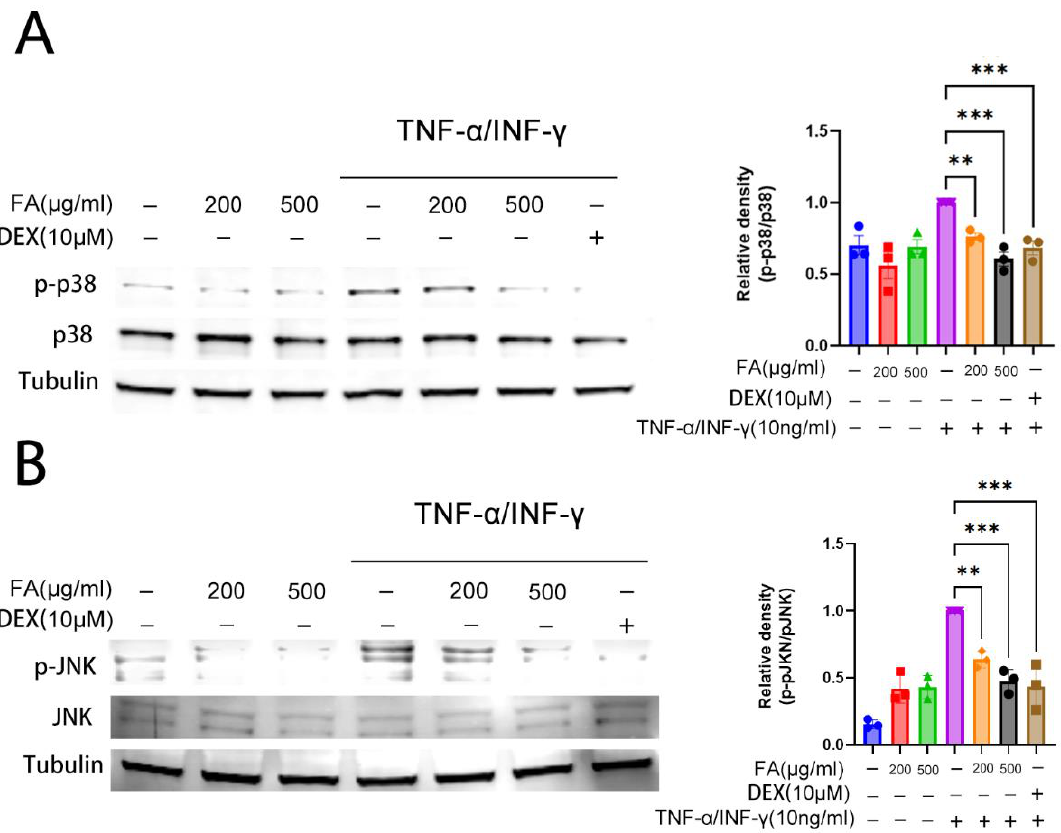
Figure 3. Effects of FA on the p38 MAPK and JNK pathways. TNF-a/IFN- γ (10 ng/mL) was added after pre-treatment with FA (200 and 500 g/mL). ( A ) p38 MAPK, ( B ) JNK Western blot and quantitative analysis. A minimum of three experiments were used to calculate the mean ± SEM., *** p < 0.001, ** p < 0.01, ns stands for not significant.